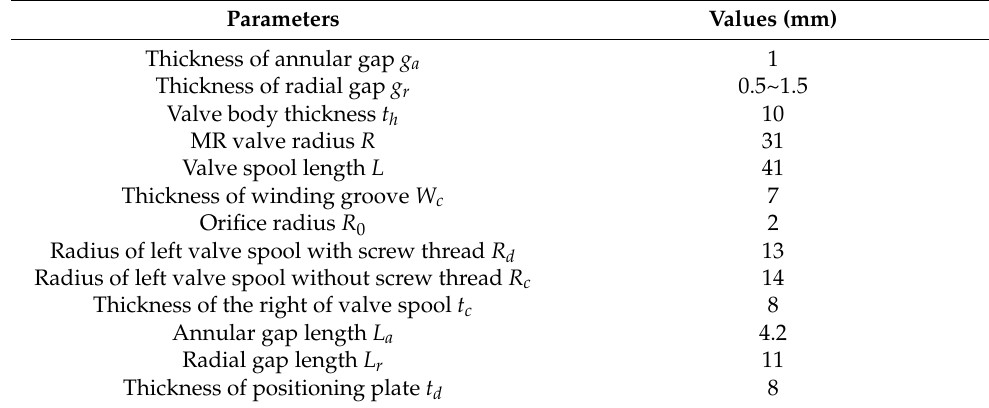
Figure 9. Photograph of the annular-radial-orifice flow MR valve: ( a ) valve parts, ( b ) valve assembly. Table 1. Relevant dimension parameters of the proposed MR